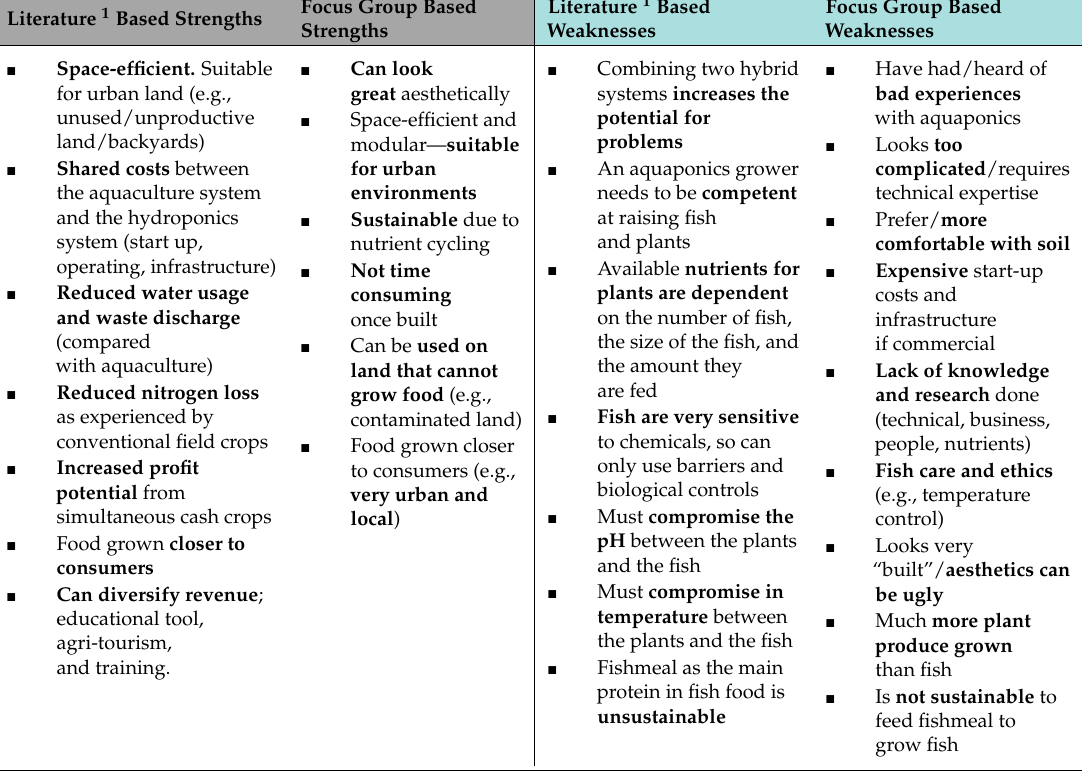
Table 1. Comparison of Strengths and Weaknesses of